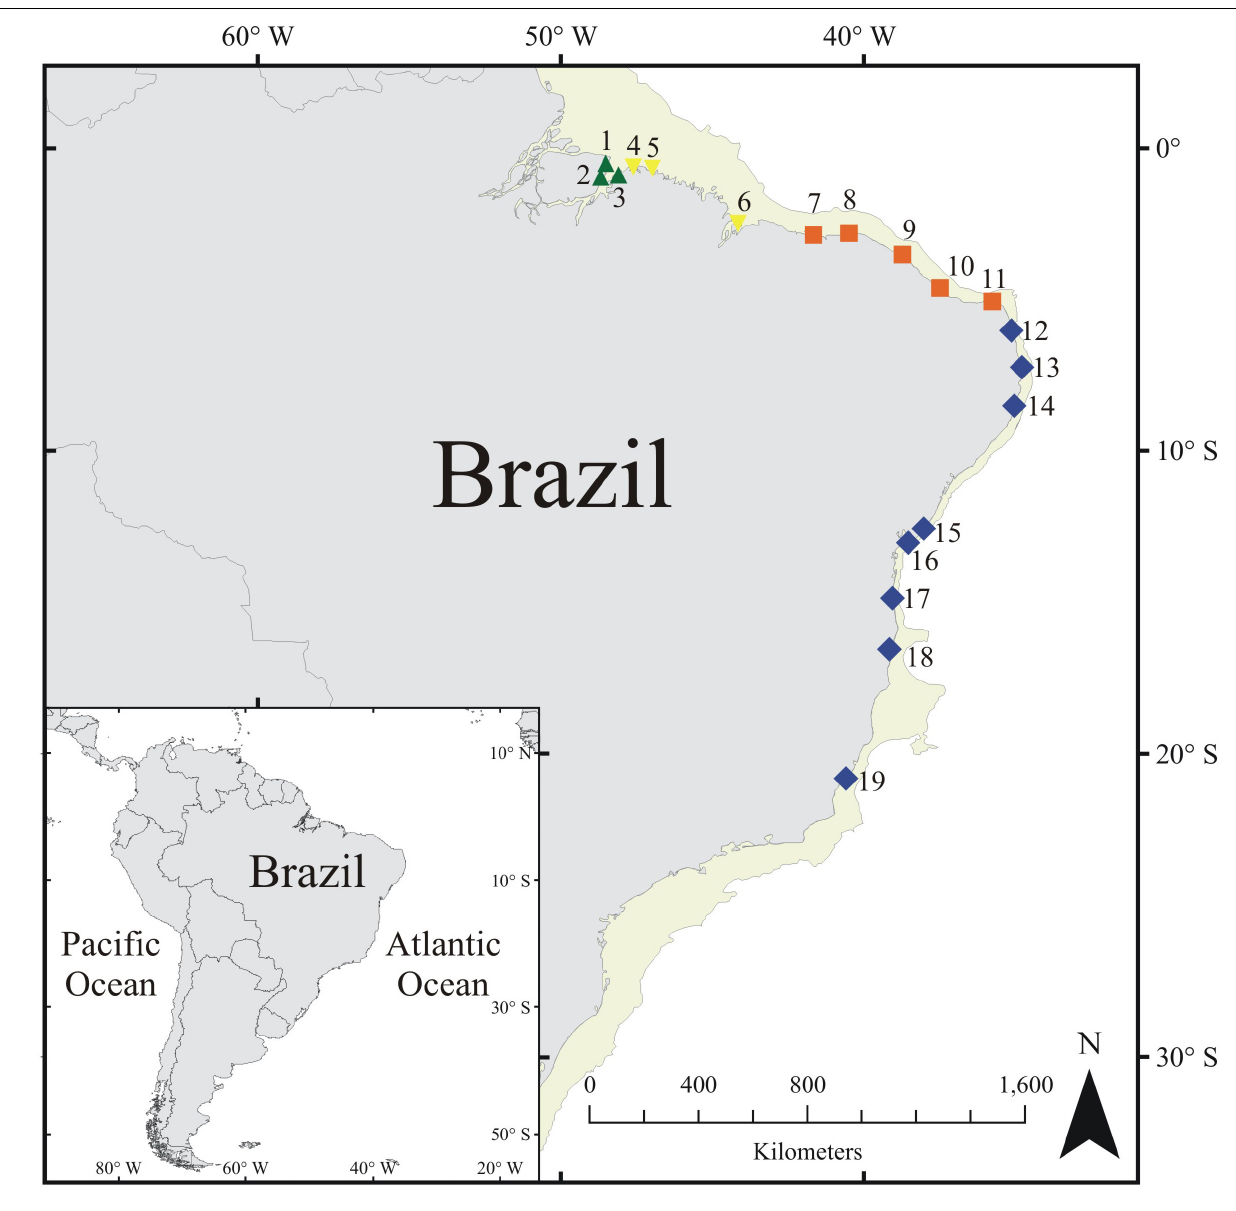
FIGURE 1 | The 19 sites sampled in our study. Each symbol and color denotes one of the four Brazilian intertidal subprovinces identified here; Amazon estuary (AE) = green triangles, Northern mangrove (NM) = yellow inverted triangles, Northeastern semiarid (NS) = orange squares, and Tropical warm (TW) = blue